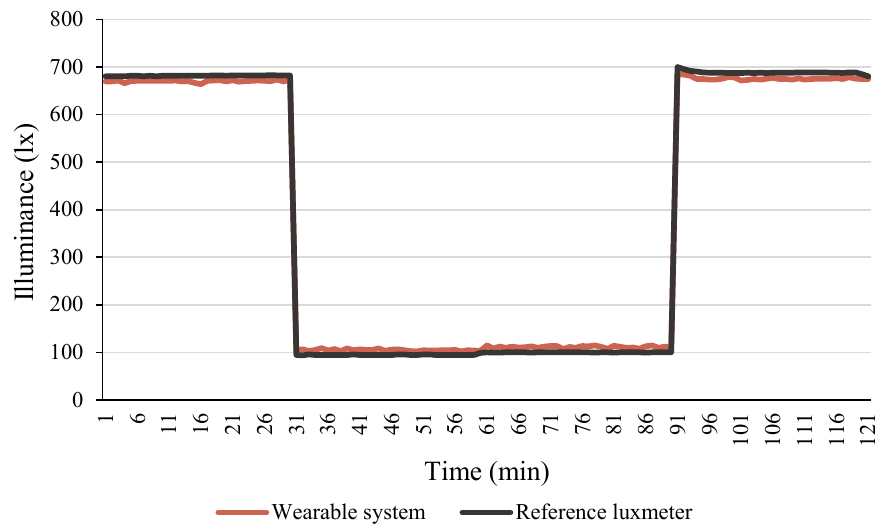
Figure 8. Illuminance registered by the developed wearable system and the reference luxmeter.